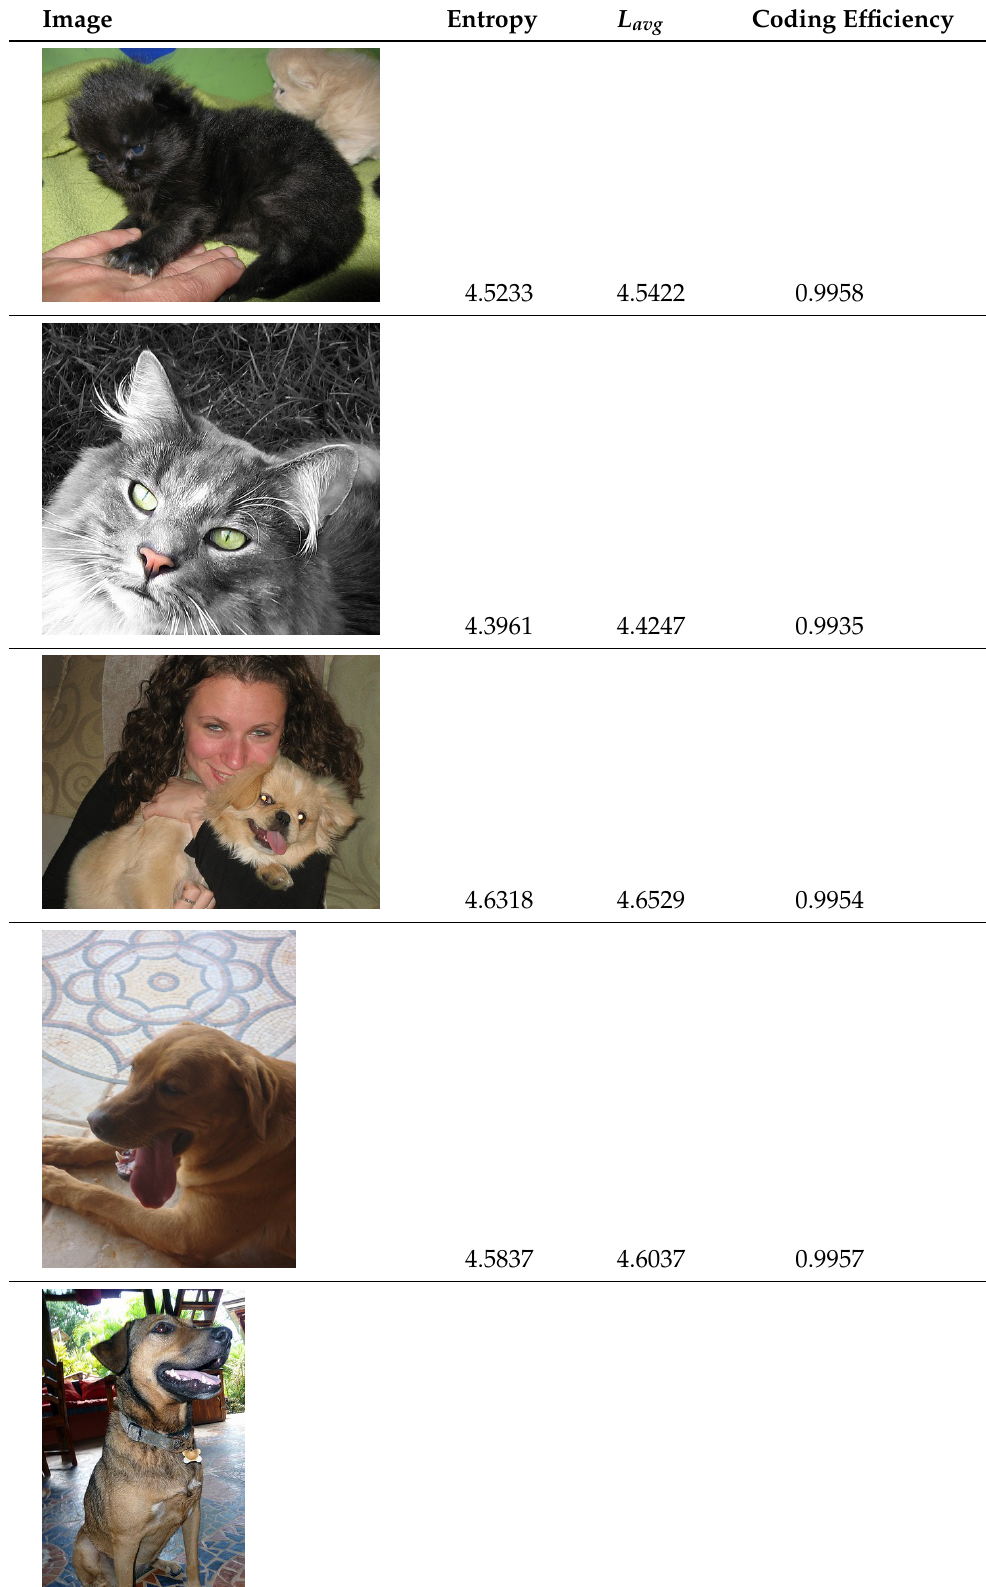
Table 9. The Huffman coding